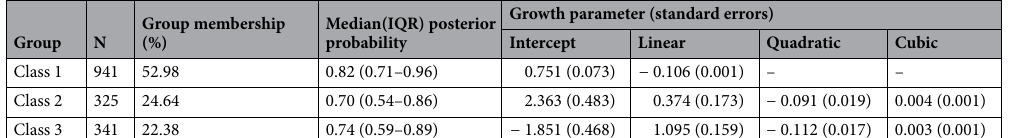
Association between BMI z‑scores trajectories and early individual, family and community factors among girls. Table 6 summarizes the results from the multivariate logistic regression examin- ing characteristics associated with trajectories membership among girls. Girls’ mother with junior/senior high school education (OR 0.658; 95% CI 0.489–0.886) and living with parents (OR 0.704, 95% CI 0.524–0.946) were less likely to belong in Class 2 trajectory than Class 1 trajectory. In contrast, girls living in the advantaged com- munities (OR 1.539; 95% CI 1.052–2.252), rural-living (OR 1.558; 95% CI 1.133–2.142) and with none social integration (OR 1.496; 95% CI 1.07–2.091) were more likely to belong in Class 2 trajectory than Class 1 trajec- tory. Girls having a longer breastfeeding duration(≥ 6 months) (OR 1.469; 95% CI 1.035–2.087) were more likely